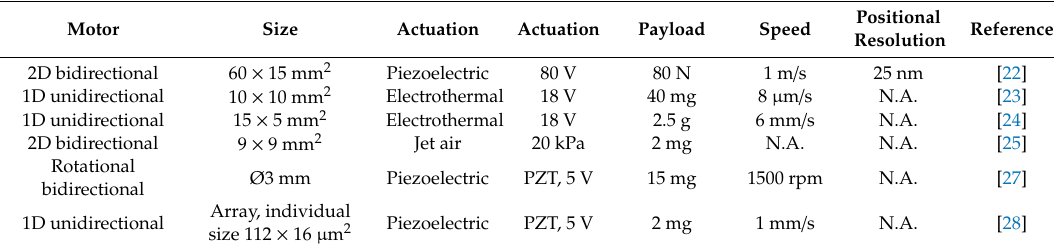
Table 1. State of the art of miniature linear motors.